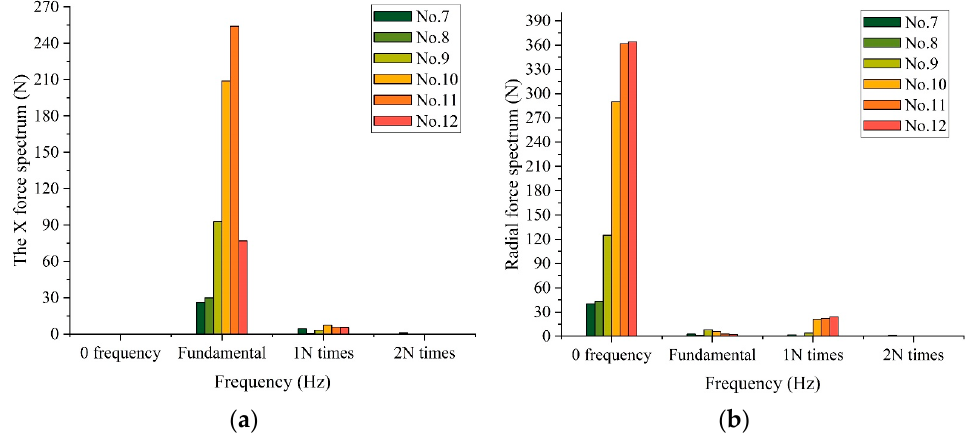
Figure 12. Frequency spectrum analysis of drilling cutting load. ( a ) Force in X-direction. ( b ) Resultant force in radial direction.